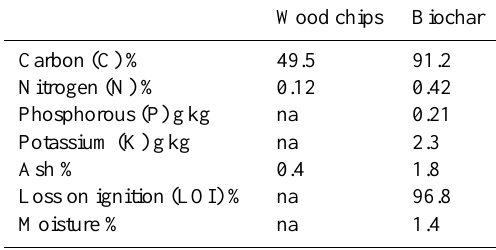
Table 1. Properties of the biochar and feedstock (wood chips) used for biochar production. (Khanal, 2011; Wiedner et al., 2013). Wood